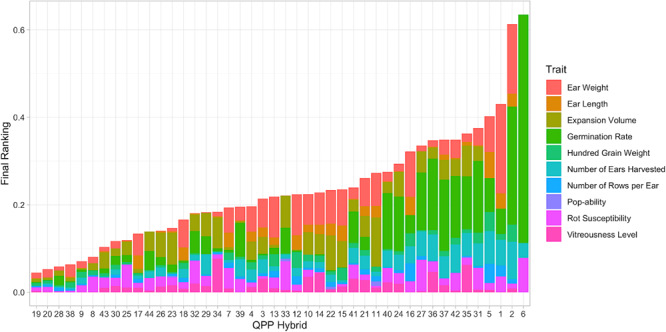
Categorized results from hybrid ranking model. Elite hybrids determined from the Ranking Model are listed from left to right as summed ranking value increases. Lower score indicates less distance from maximum trait value, i.e., Hybrid 19 ranked best compared to all hybrids. Stacked bars represent individual trait influence on each hybrid’s overall rank.